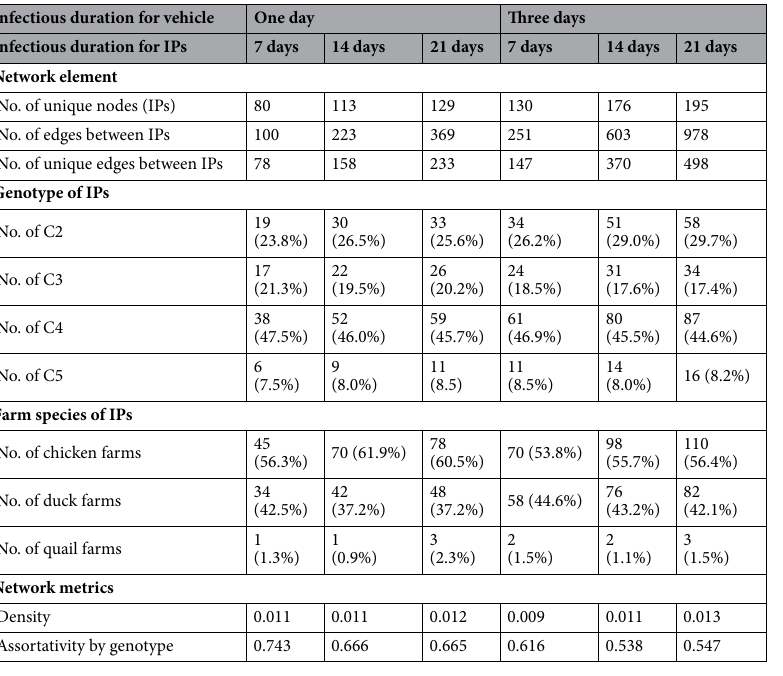
Table 1. Overview of the characteristics of the contact networks between all HPAI H5N6 genotypes of infected premises. The networks were built based on the three different infectious duration for infected farms and two infectious durations for potentially contaminating vehicle movements. HPAI highly pathogenic avian influenza, IP infected